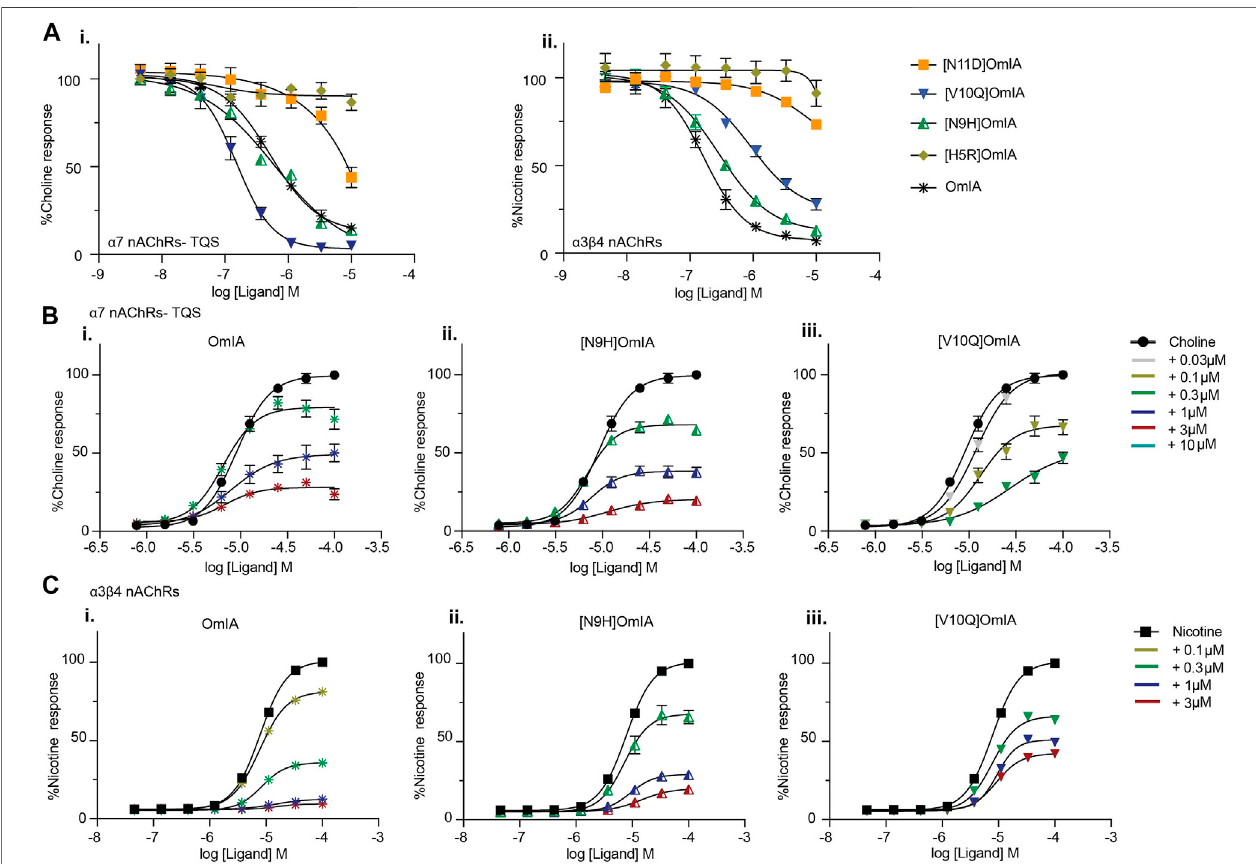
FIGURE4 | Activity of OmIA and its analogues at α 7 nAChRs in the presence ofthe type II PAM TQS, and at α 3 β 4 nAChRs. (A) Inhibition ofcholine activation of α 7 nAChR in the presence of TQS (i) and inhibition of nicotine activation of α 3 β 4 nAChRs (ii) by OmIA and analogues using FLIPR Ca 2+ in fl ux assay results in SH-SY5Y cells Concentration-response curves for nicotine ( fi lled square) and choline ( fi lled circle) in the presence of varying concentrations of OmIA (i), [N9H]OmIA (ii) and [V10Q]OmIA (iii) at TQS- α 7 nAChRs (B) and at α 3 β 4 nAChRs (C) . Data represent mean ± SEM of triplicate data from three independent experiments.